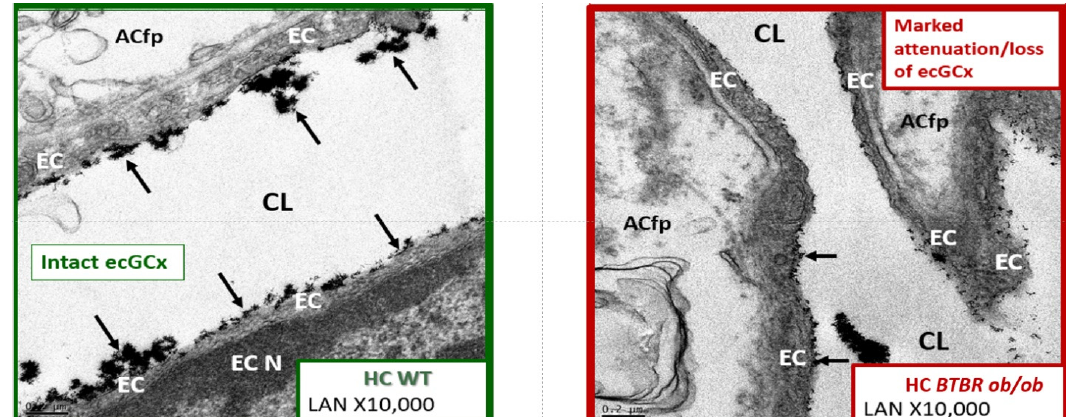
Figure 8. Lanthanum nitrate (LaN) staining of the endothelial glycocalyx (ecGCx) showing attenuation and loss in the obese diabetic BTBR ob/ob model: hippocampus CA-1 regions. Note the highly decorated endothelium by LaN staining in the control wild type (WT) hippocampus (HC) model with intact ecGCx (left-hand figure). In the obese diabetic BTBR ob/ob model, the ecGCx (arrows) when present is markedly attenuated and very thinned (right-hand figure). Magnification ×10,000; bar = 0.2µm. ACfp = astrocyte foot process; CL = capillary lumen; EC = endothelial cell; HC = hippocampus; WT = wild type control.